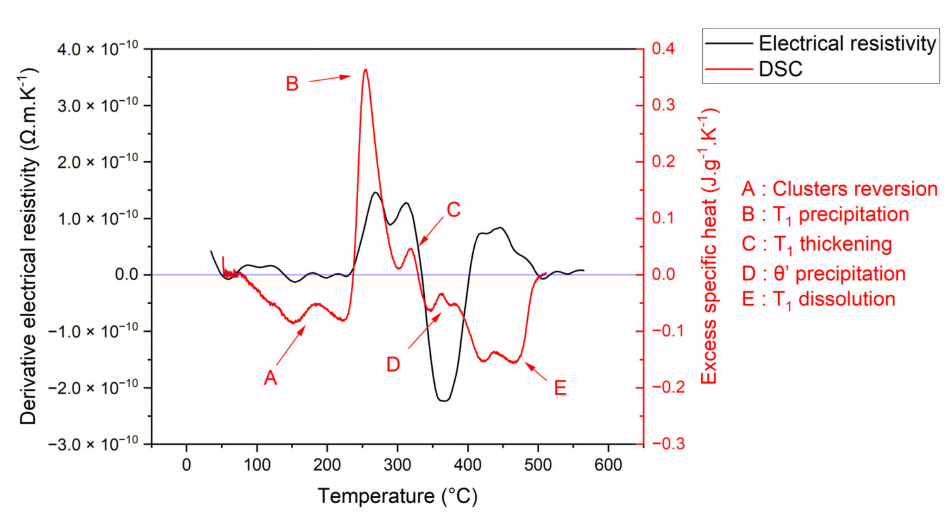
Figure 2. DSC and electrical resistivity curves for AA2050-T34 alloy with a heating rate of 20